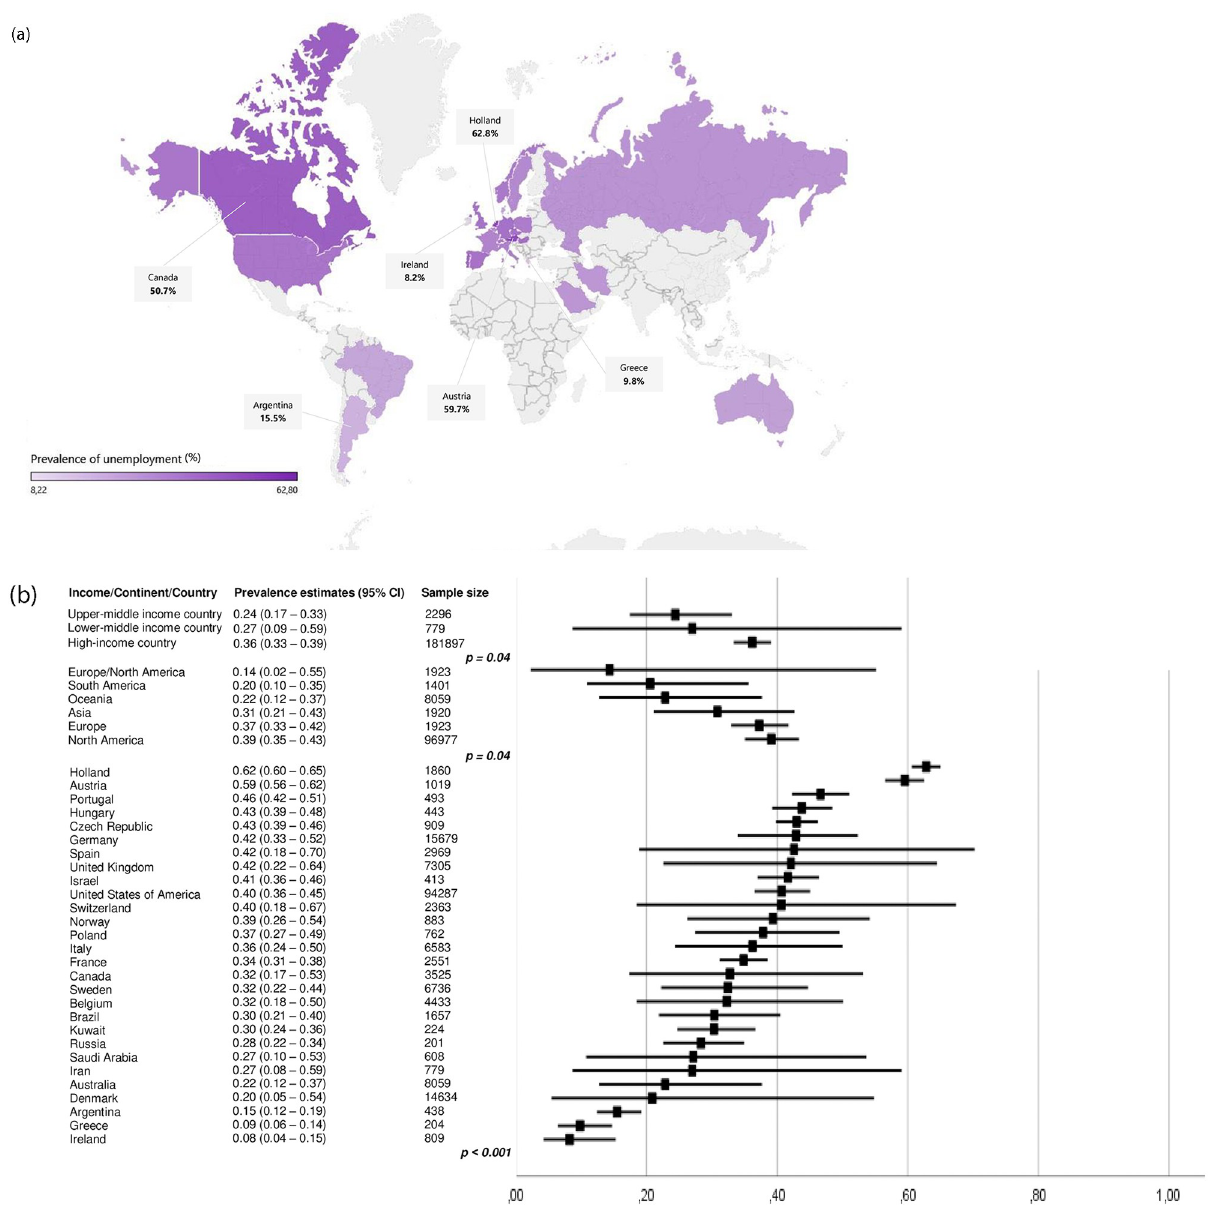
Fig 4. Prevalence of unemployment (%) according to geographical